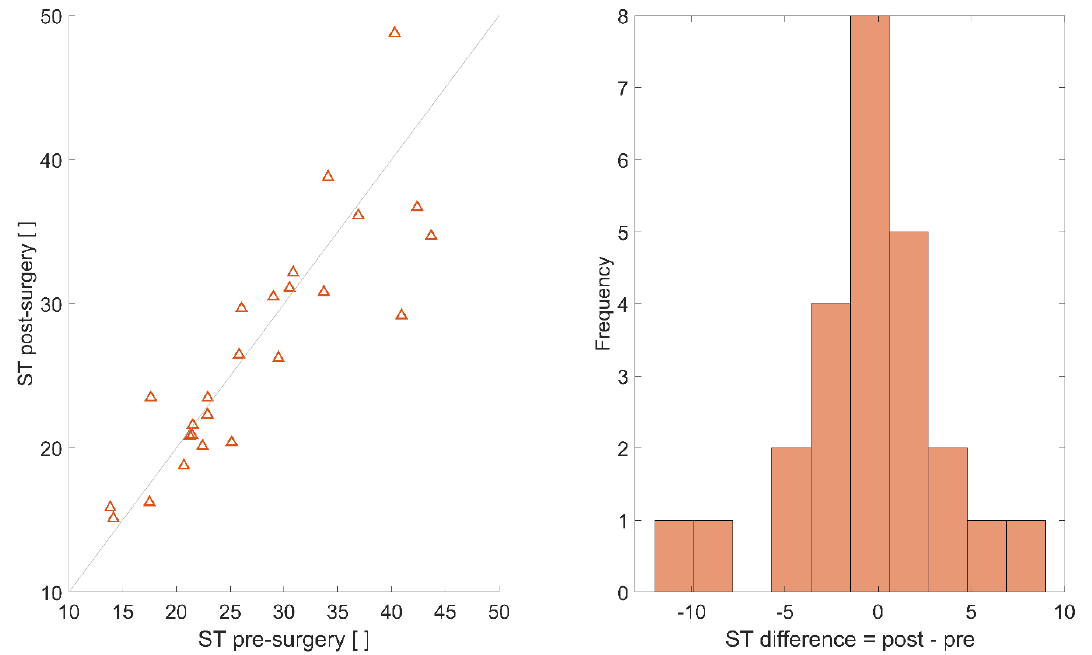
Figure A2. A scatterplot showing stability index (ST) data before and after (6 weeks) HTO surgery. The solid line is the one-to-one line. If there was no change between the two tests, the data point would fall on the one-to-one line. Points above this line indicate higher scores following the surgical intervention. △ , HTO individual data.